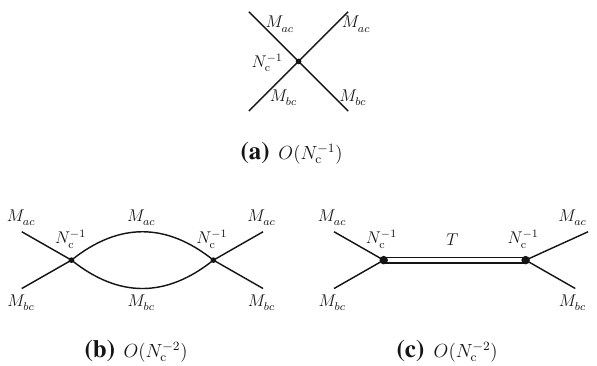
Fig. 17 Four-meson vertex ( a ), two-meson intermediate states ( b ) and tetraquark state ( c ) arising from the correlation function (3.12)